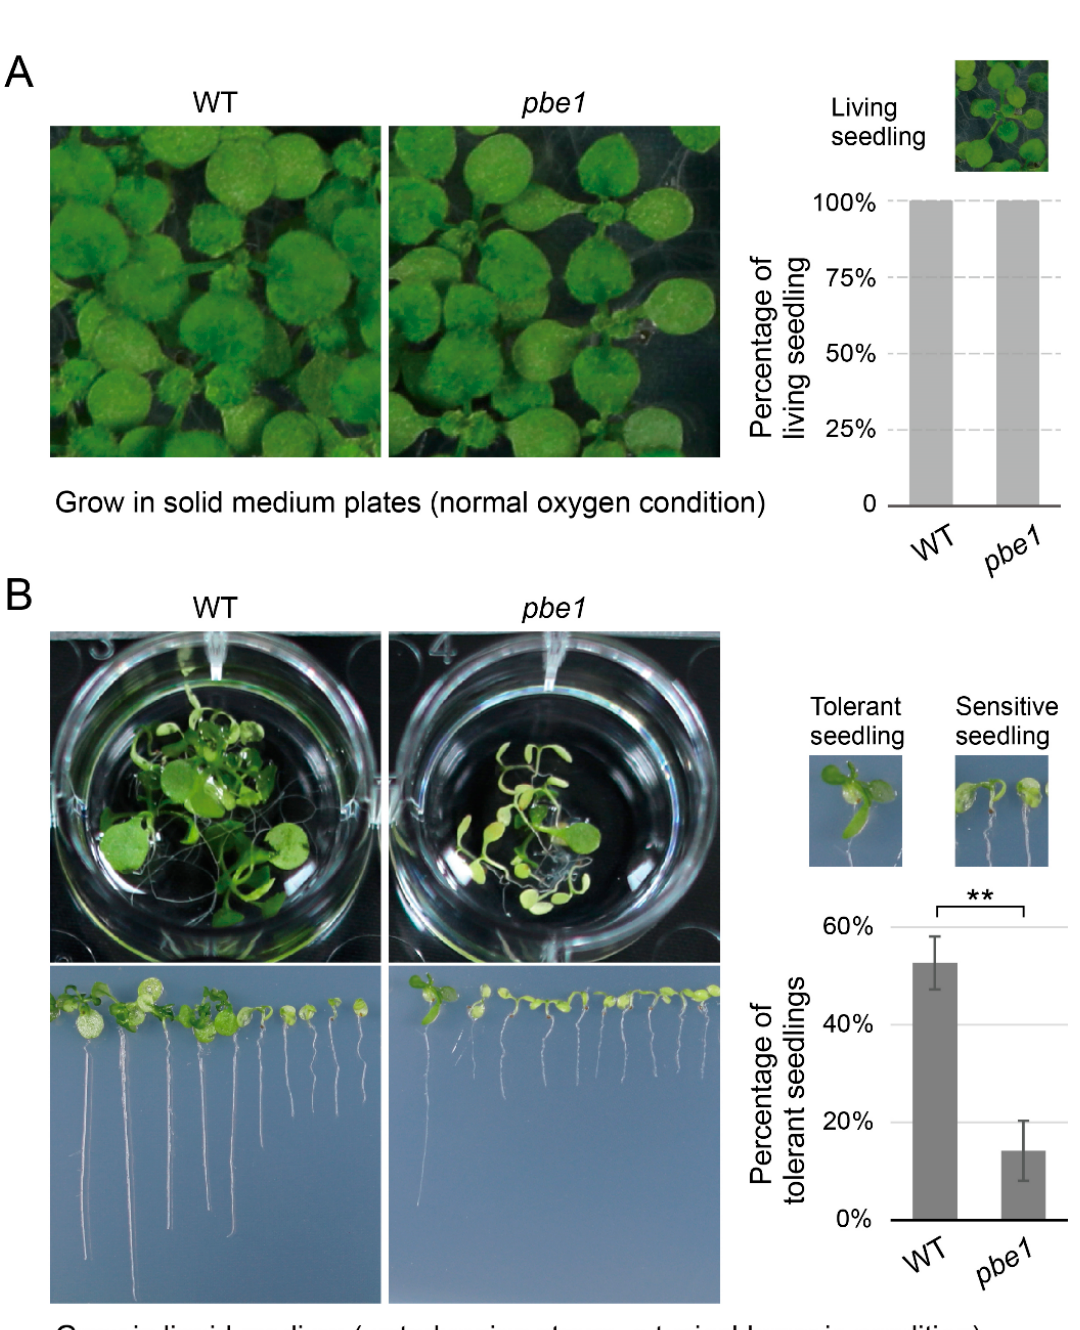
Figure 4. The pbe1 mutant is hypersensitive to hypoxia stress. ( A ) WT and pbe1 mutant plants grow in half-strength MS medium plates under normoxic (normal oxygen) conditions. Under normoxic conditions, the percentages of living seedlings of pbe1 mutant and WT plants were both 100%. ( B ) The percentage of seedlings tolerant to waterlogging stress in WT plants was significantly higher than that in pbe1 mutant plants. WT and pbe1 mutant plants grow in plates for five days and then move to a liquid medium (waterloggingstress, atypicalhypoxiccondition)andgrowforapproximately13days. Underwaterlogging stress, tolerant seedlings can produce true leaves, while sensitive seedlings have only cotyledons. Data are the mean ± SD. Significance analysis of differences was performed by t -test (** p <